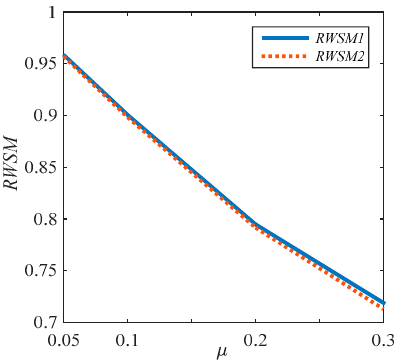
Figure 11. The trends of the two minima of RWS with the crack depths.